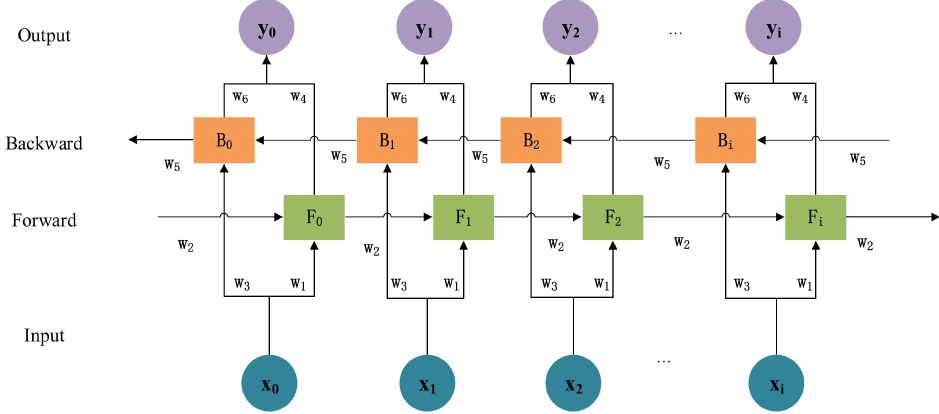
Figure 5. Bi-LSTM typical network [41].